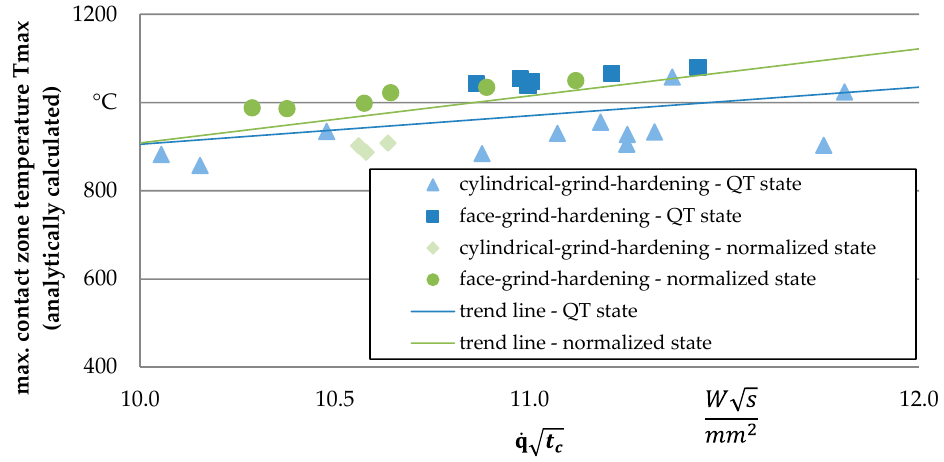
Figure 3. The maximum contact zone temperature T max versus the heat flux to the workpiece and the √ . contact time q · t c .